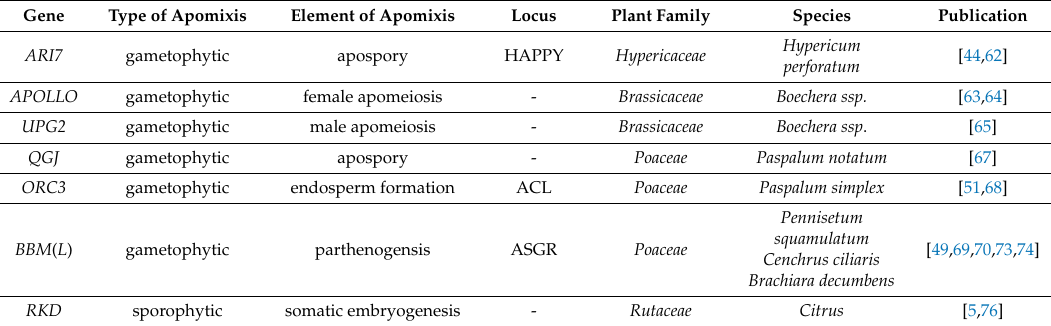
Table 1. Candidate genes for apomixis encoded from apomixis linked